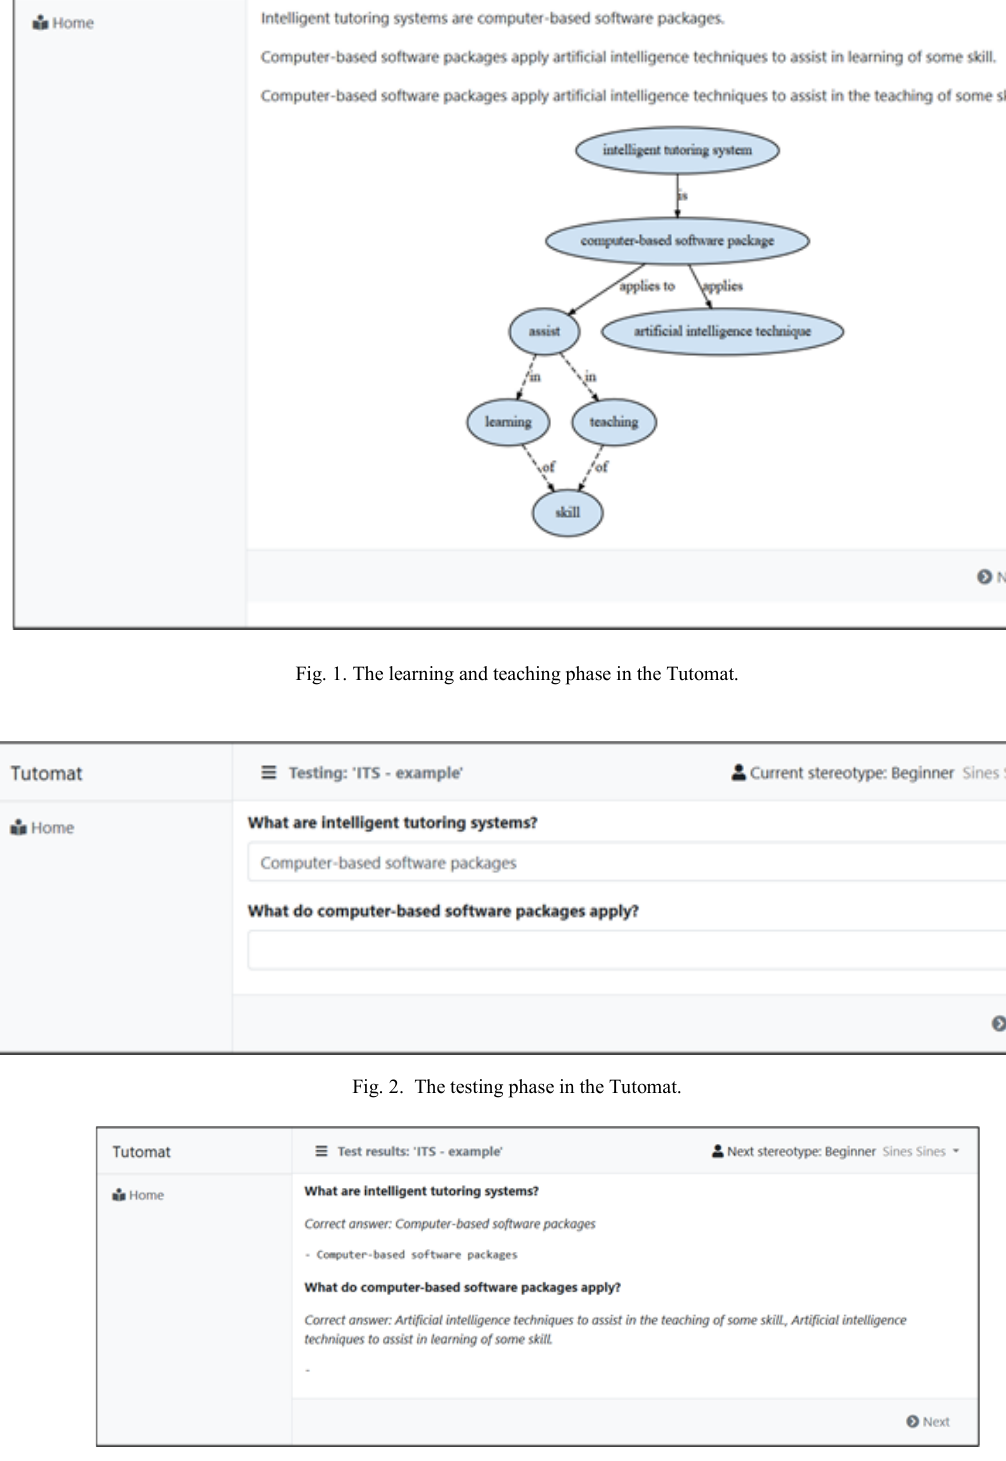
Fig. 3. The evaluation phase in the